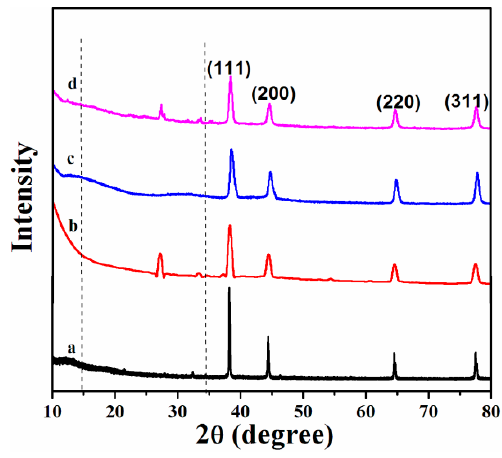
Figure 1. XRD patterns of ( a ) AgNPs and ( b ) PS/AgNPs; ( c ) PMMA/AgNPs; and ( d ) PSMMA/AgNPs